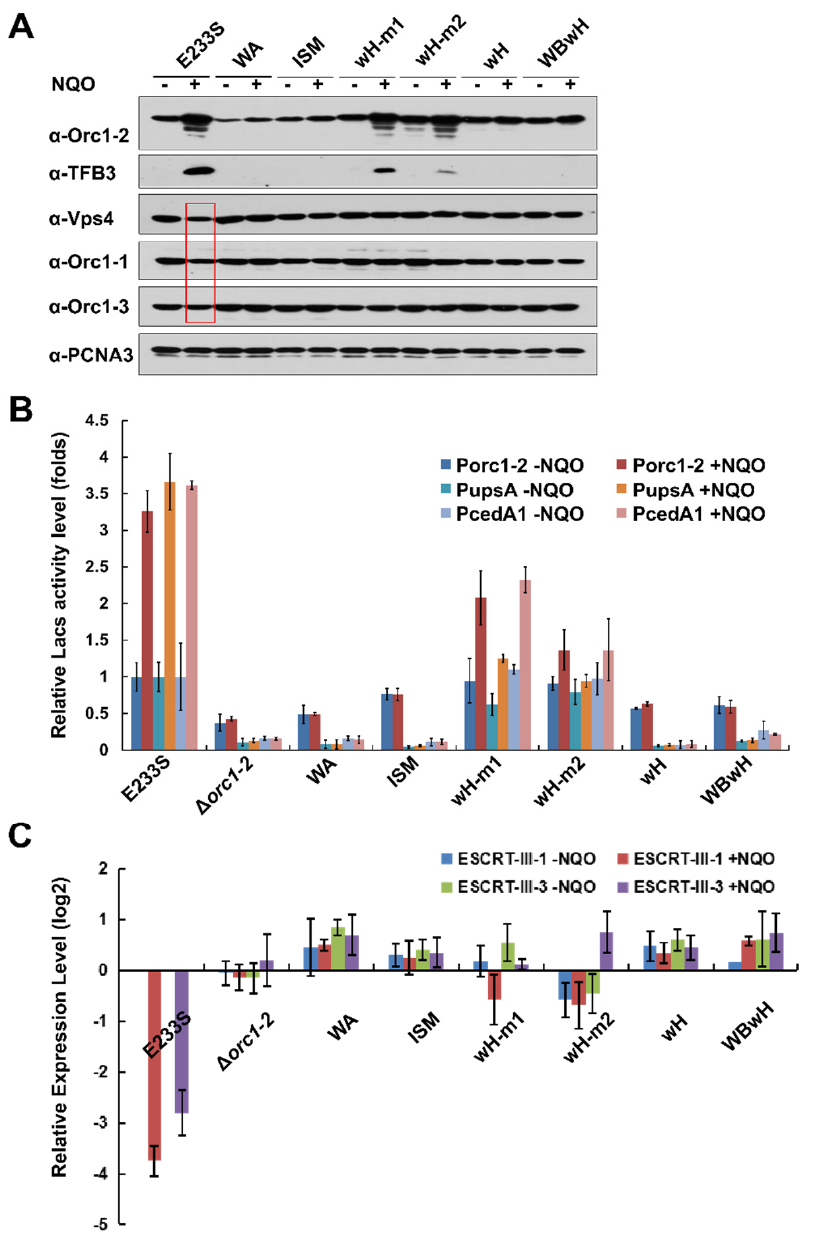
Figure 2. NQO-responsive expression of DDR genes in different orc1-2 mutants. ( A ) Western blot analysis of selected DDR genes. PCNA3 (one of the subunits of the replication clamp) was used as the loading reference. E233S, WT strain; WA, K72A at Walker A motif; ISM, G127DL128D at the initiator specific motif (ISM); wH-m1, R353AR354A at the wH domain; wH-m2, R381AR383A at the wH domain; wH, quadruple substitutions at wH domain; WBwH, pentuple substitutions at Walker B motif and wH domain. ( B ) Reporter gene assay of three highly up-regulated genes ( orc1-2 , upsA and cedA1 ). Cell extracts prepared from cultures of E233S and orc1-2 mutants carrying reporter gene plasmid of each promoter were assayed for B -glycosidase activity. ( C ) RT-qPCR of ESCRT-III-1 and ESCRT-III-3 . The expression level of 16SRNA was used to normalize the data. Saccharolobus cells were grown in the presence or absence of 2 µ M NQO (indicated as +NQO and − NQO, respectively) for 6 h. Cell mass was collected from each culture with which cell extracts were prepared for Western blot analyses and for reporter gene assay, whereas total RNAs were prepared for RT-qPCR